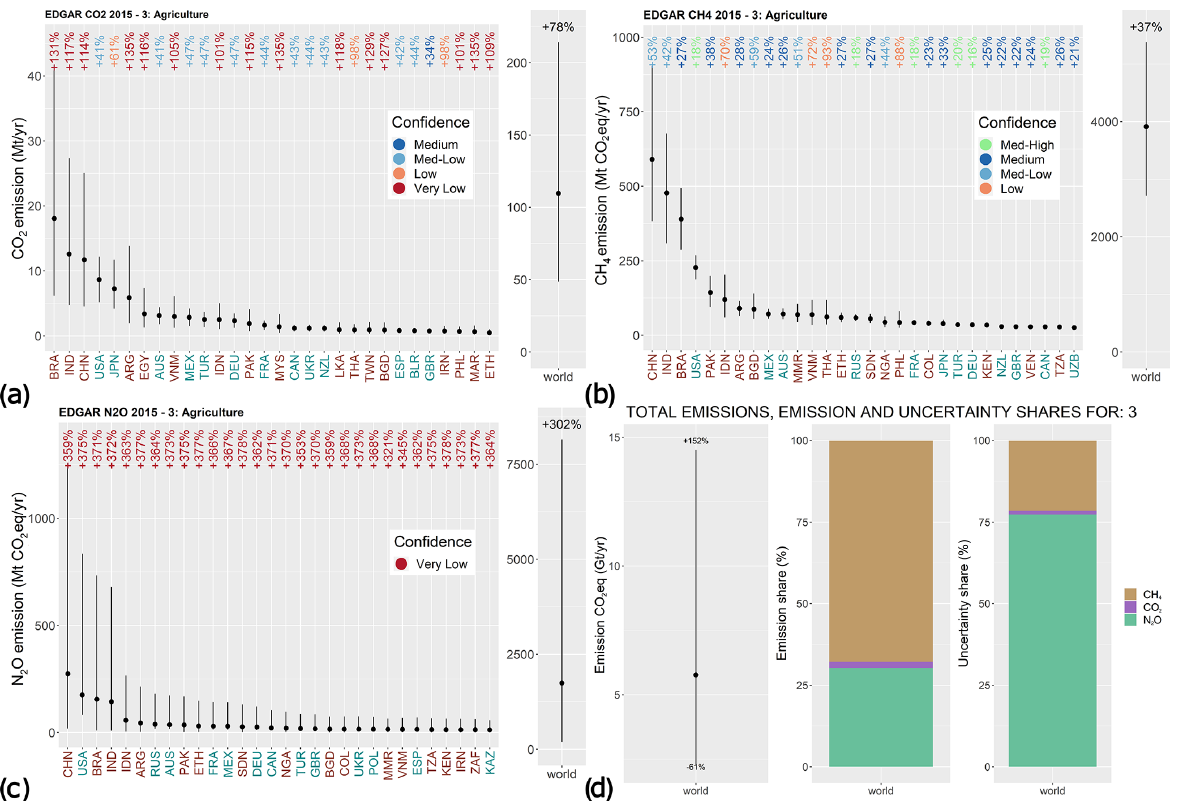
Figure 7. GHG emissions from the top emitters and the world for sector 3 (agriculture), in CO 2eq . : (a) CO 2 ; (b) CH 4 ; (c) N 2 O; (d) the world total emission uncertainty and the world emission and uncertainty shares. The country names are colour-coded according to their classification (cyan denotes industrialized, and red denotes developing). Confidence levels are given in the following ranges: high (0%, 10%]; medium-high (10%, 20%]; medium (20%, 40%]; medium-low (40%, 60%]; low (60%, 100%]; and very low > 100%. (Country codes are given in Table S1.)